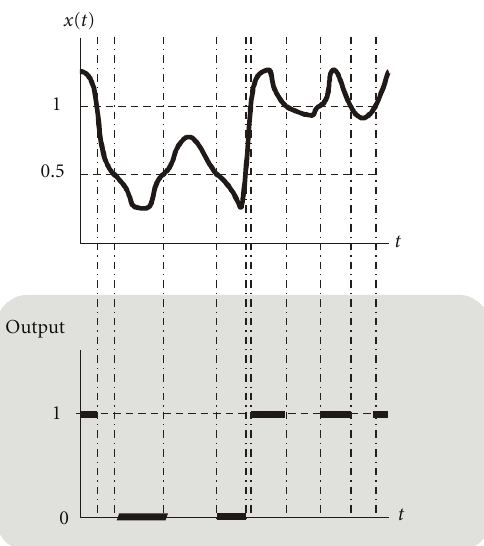
Figure 2: Discrete interpretation of continuous change of